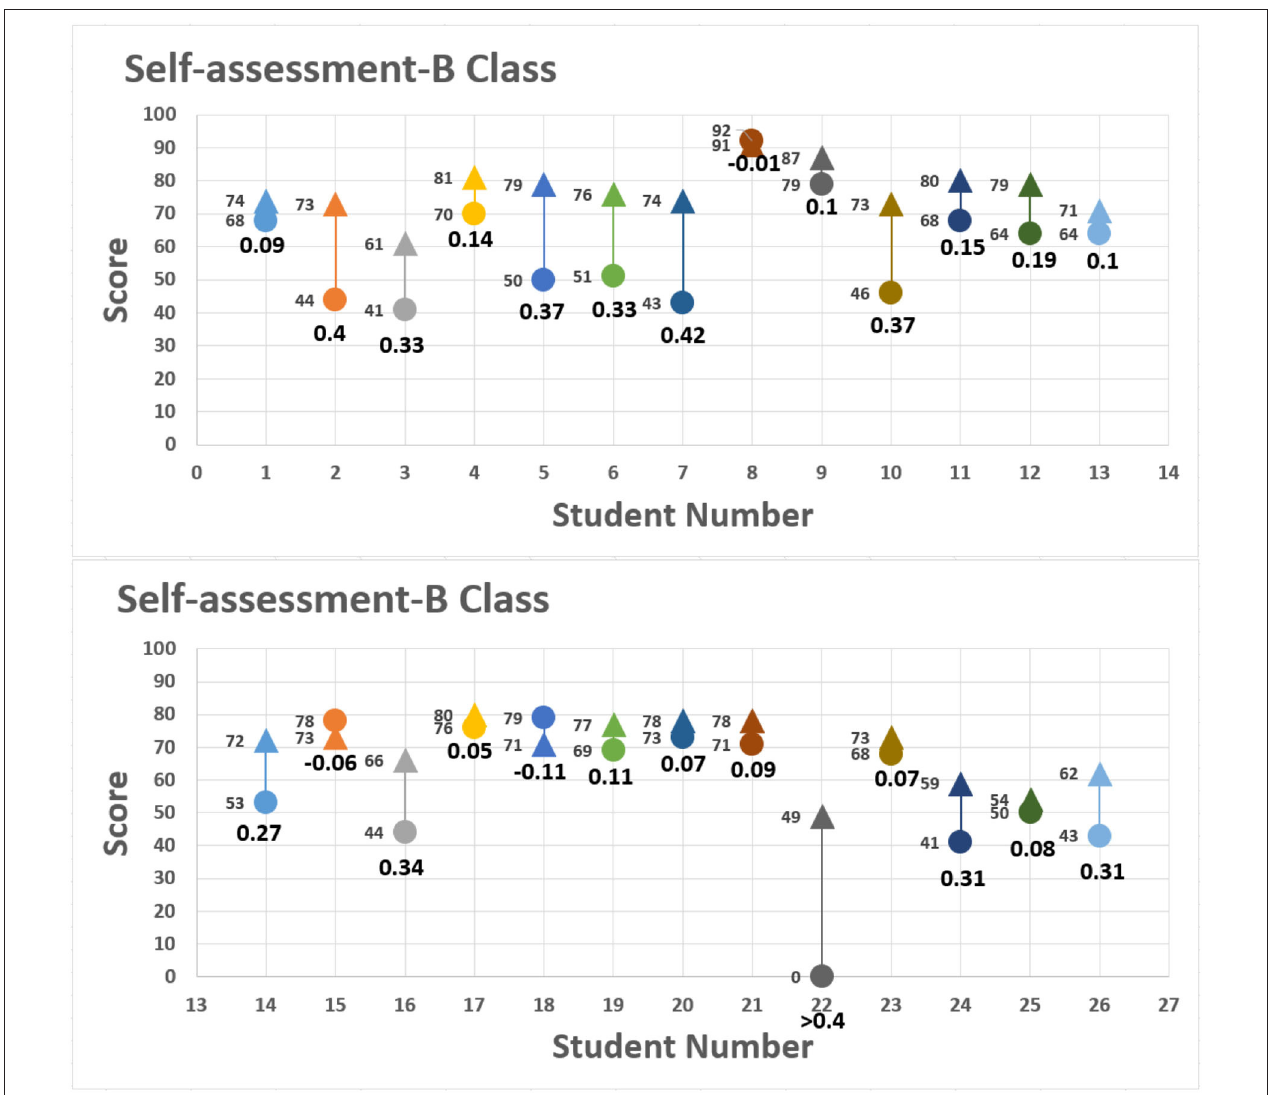
FIGURE 8 | Self-assessment: class B.